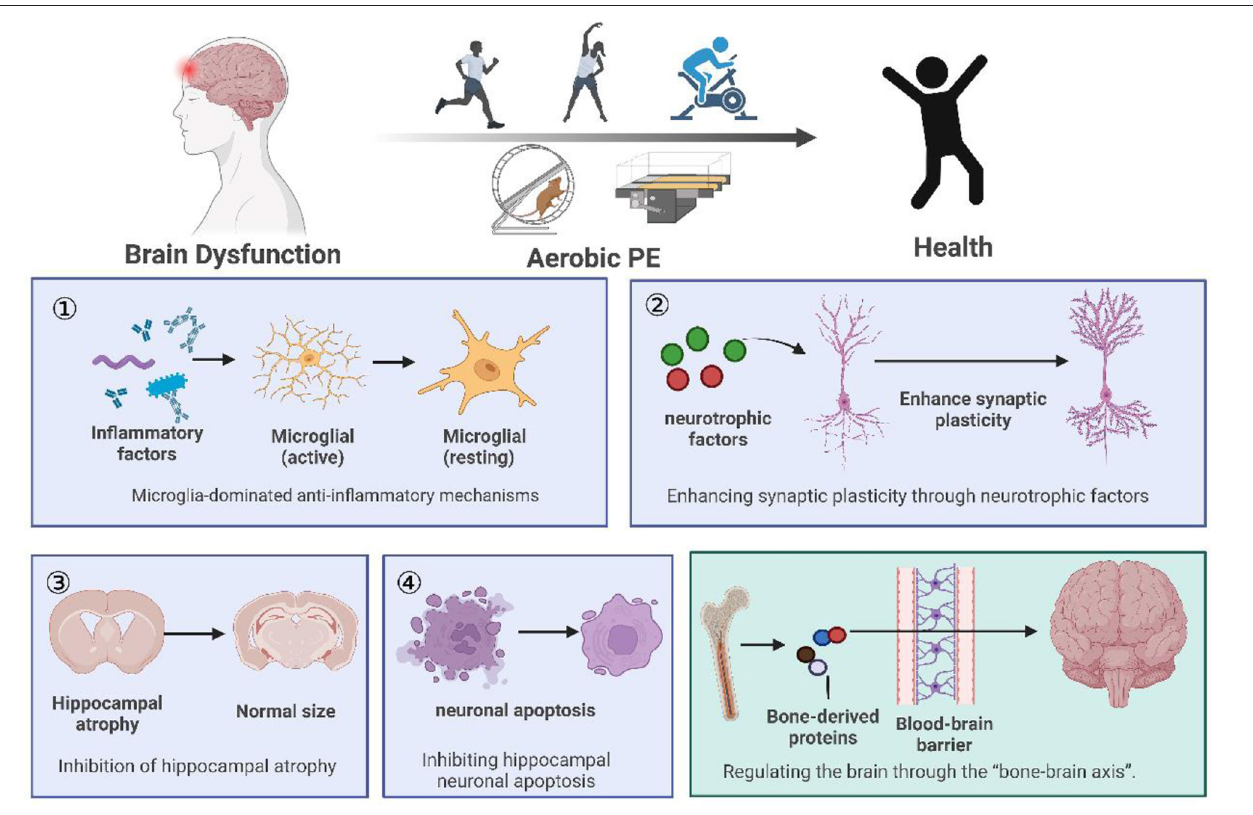
FIGURE 1 | Summary of the review. (1) We listed animal and clinical experiments on the intervention of aerobic PE in brain dysfunction, and concluded that aerobic PE can improve cognition, fight depression, and relieve chronic pain. (2) Aerobic PE interferes with brain disorder through four common mechanisms: anti-inflammatory mechanisms, synaptic plasticity, hippocampal atrophy, and hippocampal neuronal apoptosis. (3) We propose the hypothesis that aerobic PE interferes with brain disease through the bone-brain axis.